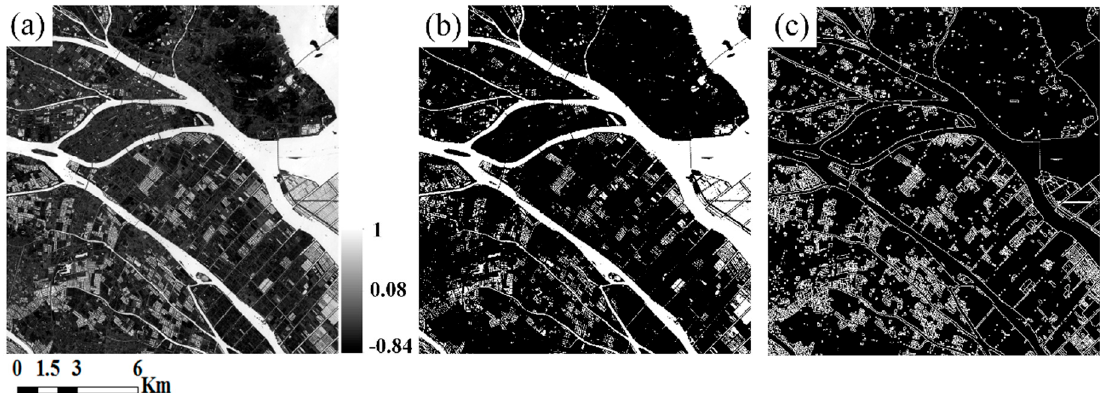
Figure 7. Pure water and mixed water-land pixels for Region E: ( a ) normalized difference water index (NDWI) image of green and SWIR1 bands; ( b ) pure water pixels (white) of NDWI with a 0.171 threshold; and ( c ) mixed water-land pixels (white).